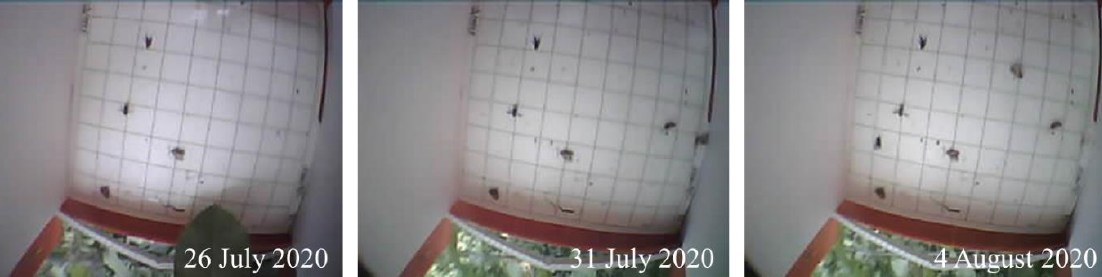
Figure 5. Experimental field images captured by the monitoring system plug-in for a trap over the 10-day period.